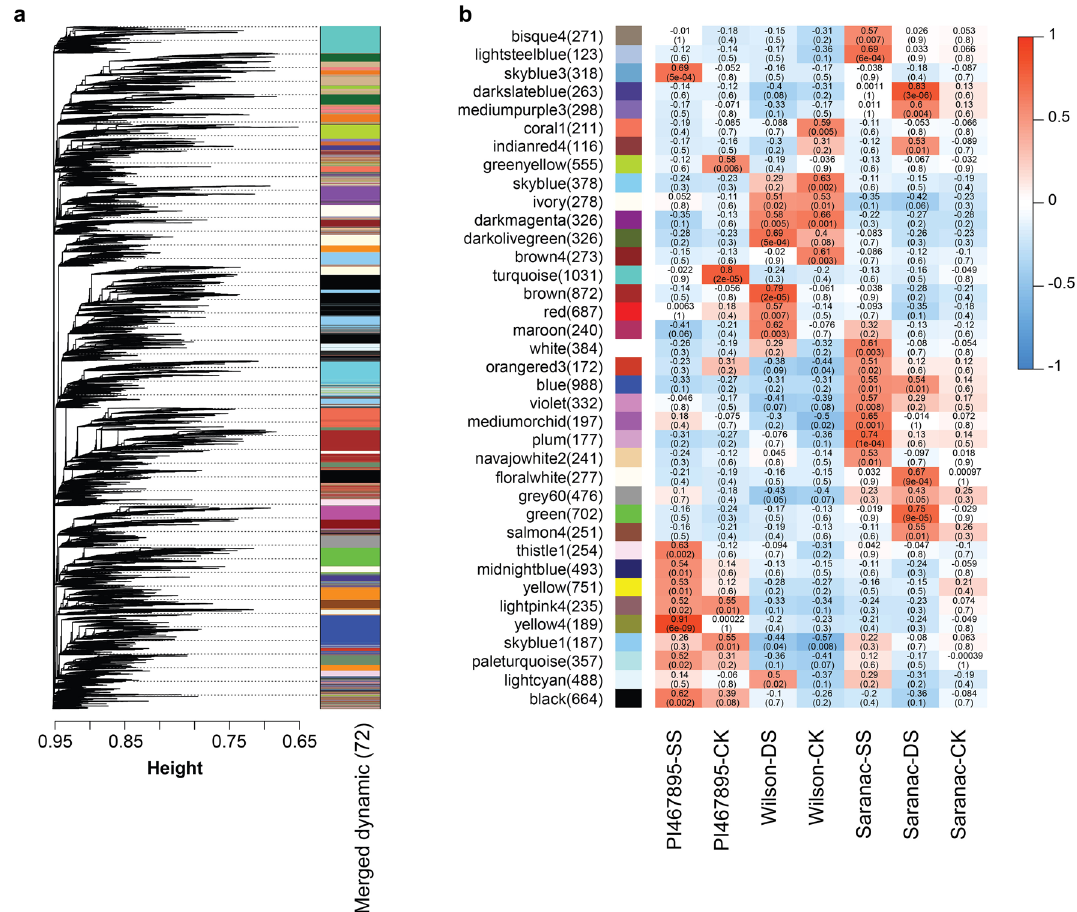
Figure 5. Gene co-expression modules detected by weighted correlation network analysis. ( a ) Clustering dendrogram of isoform expressed in all treatments based on a topological overlap matrix with merged module colors. The color rows present visual comparisons of module assignments based on the merge dynamic method. ( b ) Module-trait association among modules of isoforms by treatments: PI467895-SS, PI467895-CK, Wilson-DS, Wilson-CK, Saranac-SS, Saranac-DS and Saranac-CK. Drought stress (DS), salt stress (SS) and control non-stressed (CK). In each cell the upper values are Pearson correlations from -1 (blue) to 1 (red) and lower values are p values of